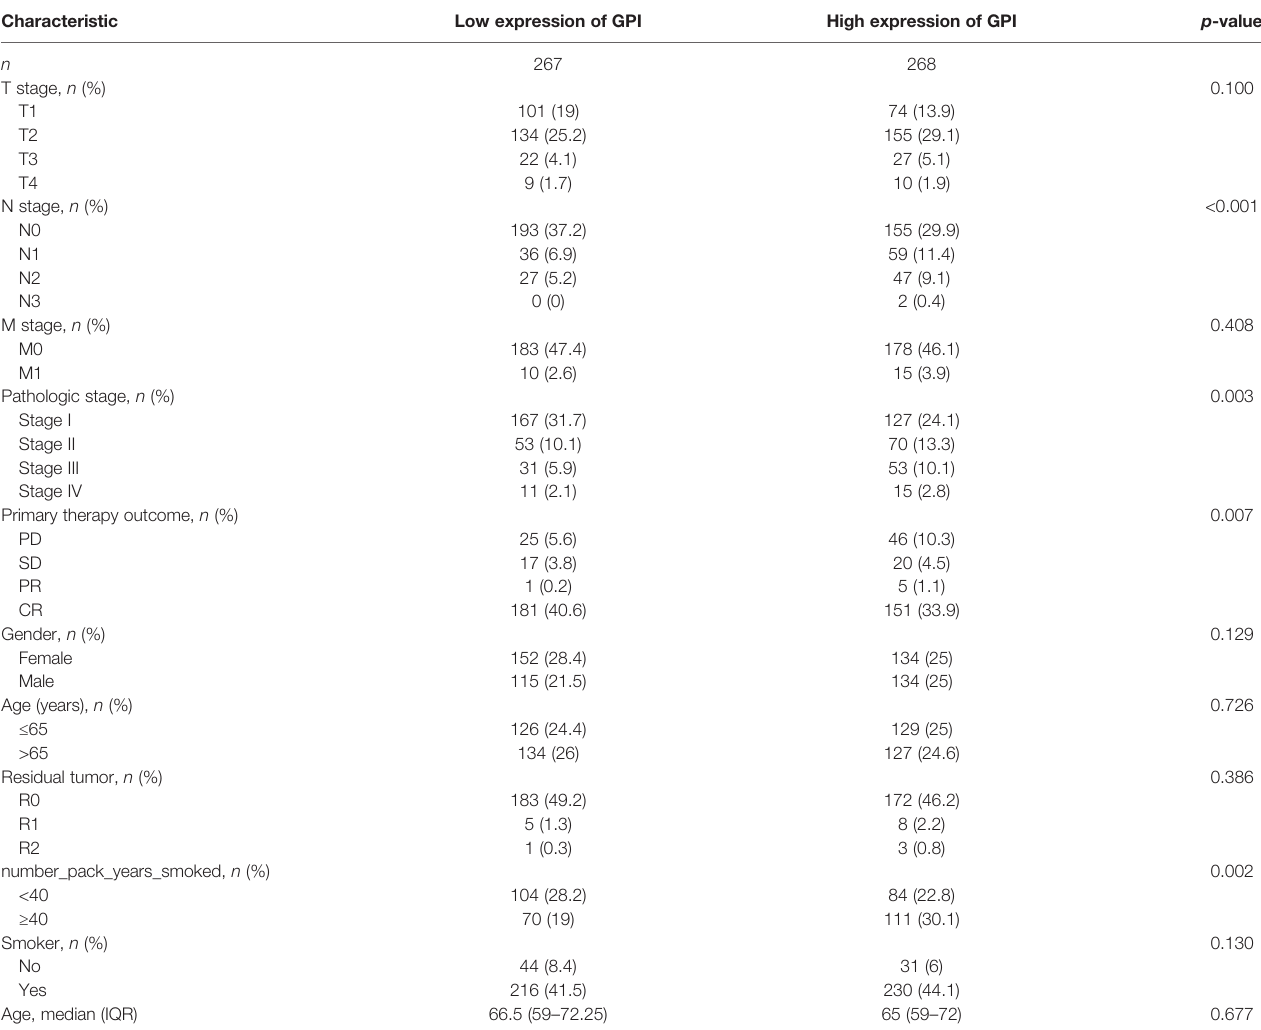
TABLE 1 | Correlation between glucose-6-phosphate isomerase (GPI) expression and the clinicopathological features of the lung adenocarcinoma (LUAD) cases from The Cancer Genome Atlas (TCGA). Characteristic Low expression of GPI High expression of